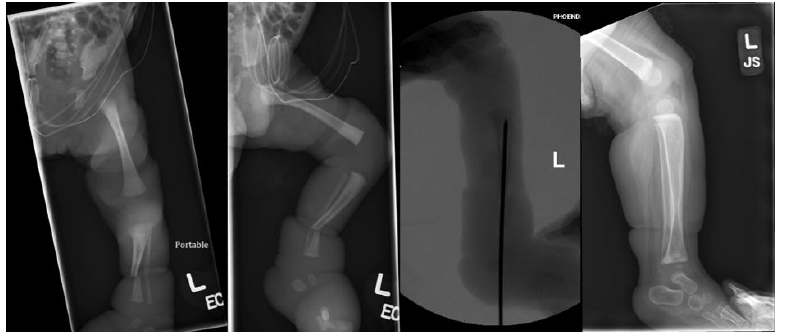
Figure 4. Radiographs of Patient 3: preoperative AP view, preoperative lateral view, intraoperative lateral view, and 1-year postoperative lateral view (left to right).